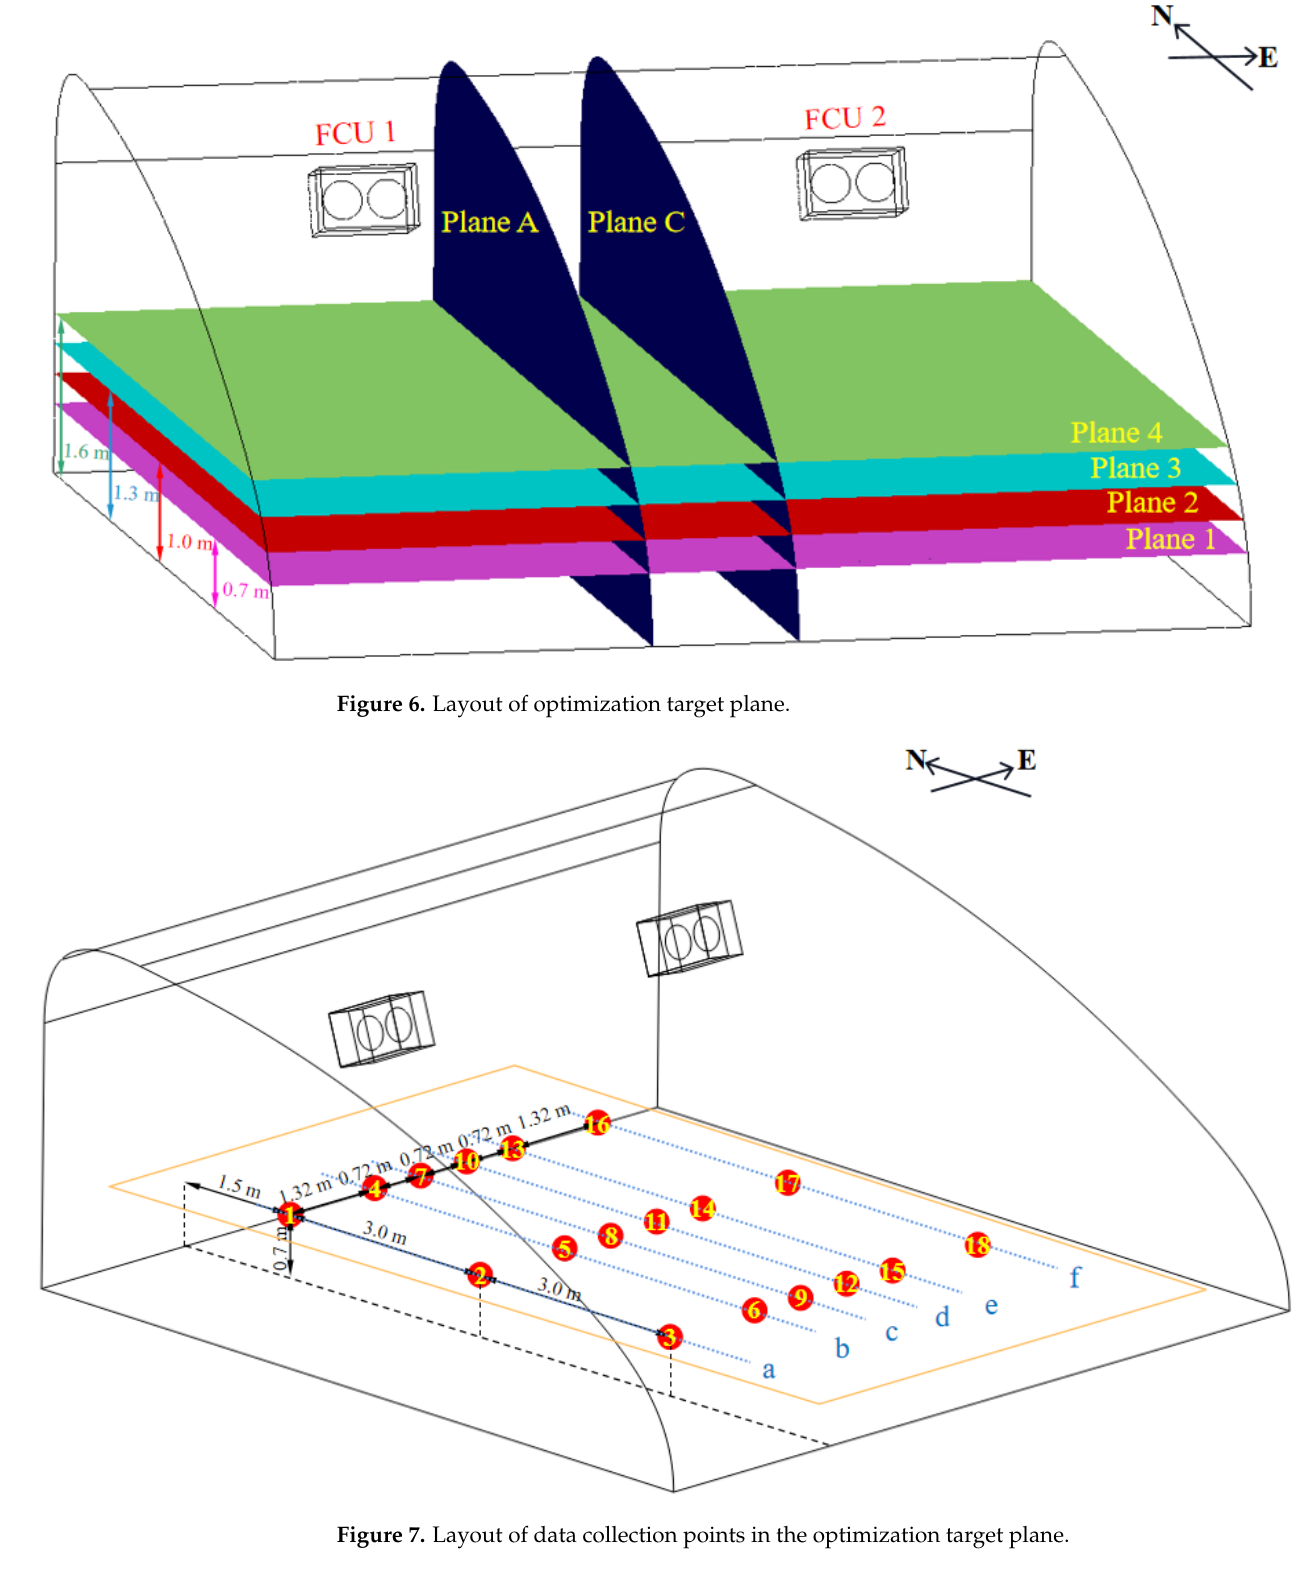
Figure 7. Layout of data collection points in the optimization target plane. 2.5.3. Evaluation Criteria for Optimized Schemes The evaluation criteria for optimized schemes was the coefficient of variation ( C v ) as shown in Equation (8). The coefficient of variation takes values from 0 to 1. Smaller values